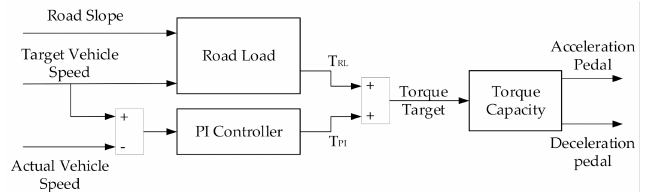
Figure 6. Driver